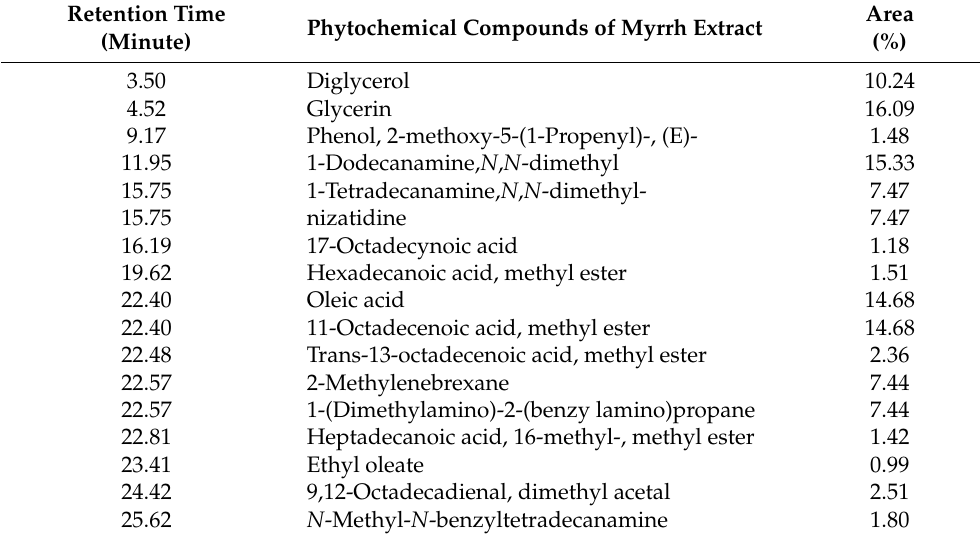
Table 2. Phytochemical analysis of myrrh extract.